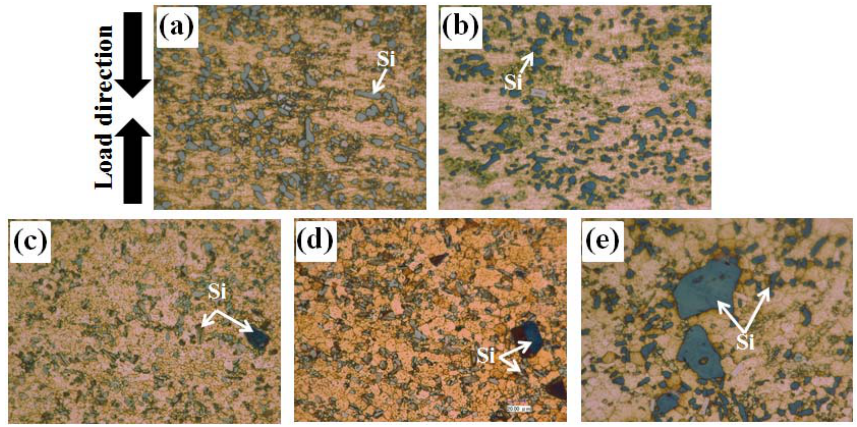
Figure 10. Optical micrographs of the deformed specimens at a strain rate of 1 /s at ( a ) 250 °C; ( b ) 300 °C; ( c ) 350 °C; ( d ) 410 °C; ( e ) 470 °C.